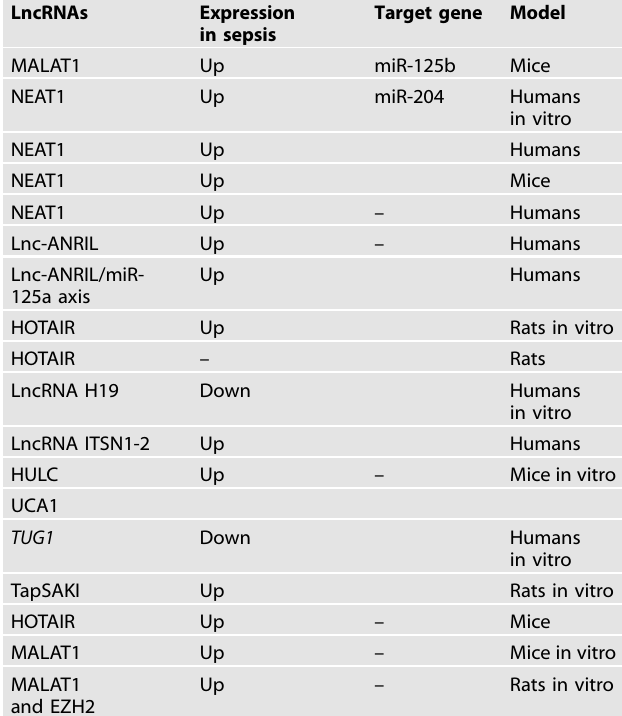
Table 1. LncRNAs related to